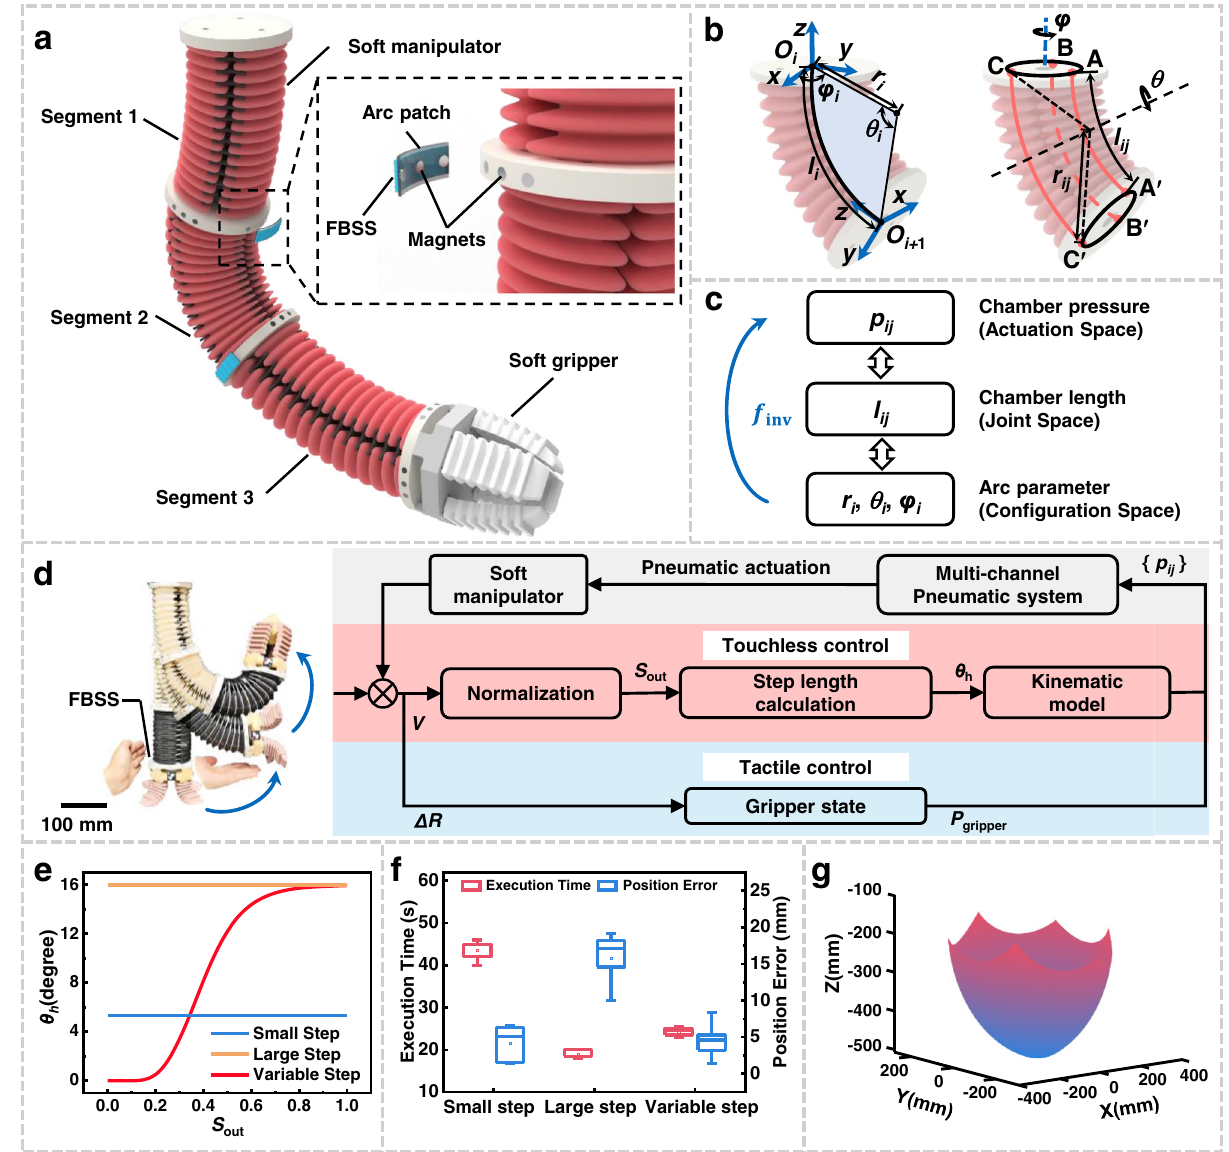
Fig. 5 | Interactive teaching kinematics control method for the soft manipulator. a A schematic view of the soft manipulator, consisting of three segments,eachcontainingthreechambersthatactuatepneumatically.TheFBSSis placed on a fl exible, arc-shaped patch with three magnets on the back. Small magnets were also placed around the bottom of each segment of the soft manip- ulator, so the position of the FBSS can be quicklyshifted. b Geometric functions in thebendingsegment,where φ i isthesegmentde fl ectionanglearoundthez-axis; θ i isthesegmentcurvatureanglearoundthey-axis; r i isthesegmentcurvatureradius; l i isthearclengthofthesegment; r ij isthecurvatureradiusofeachactuator; l ij isthe arc length of each actuator. c The actuation, joint, and con fi guration spaces and mapping between them, de fi ne the inverse kinematics ( f inv ). d The closed-loop